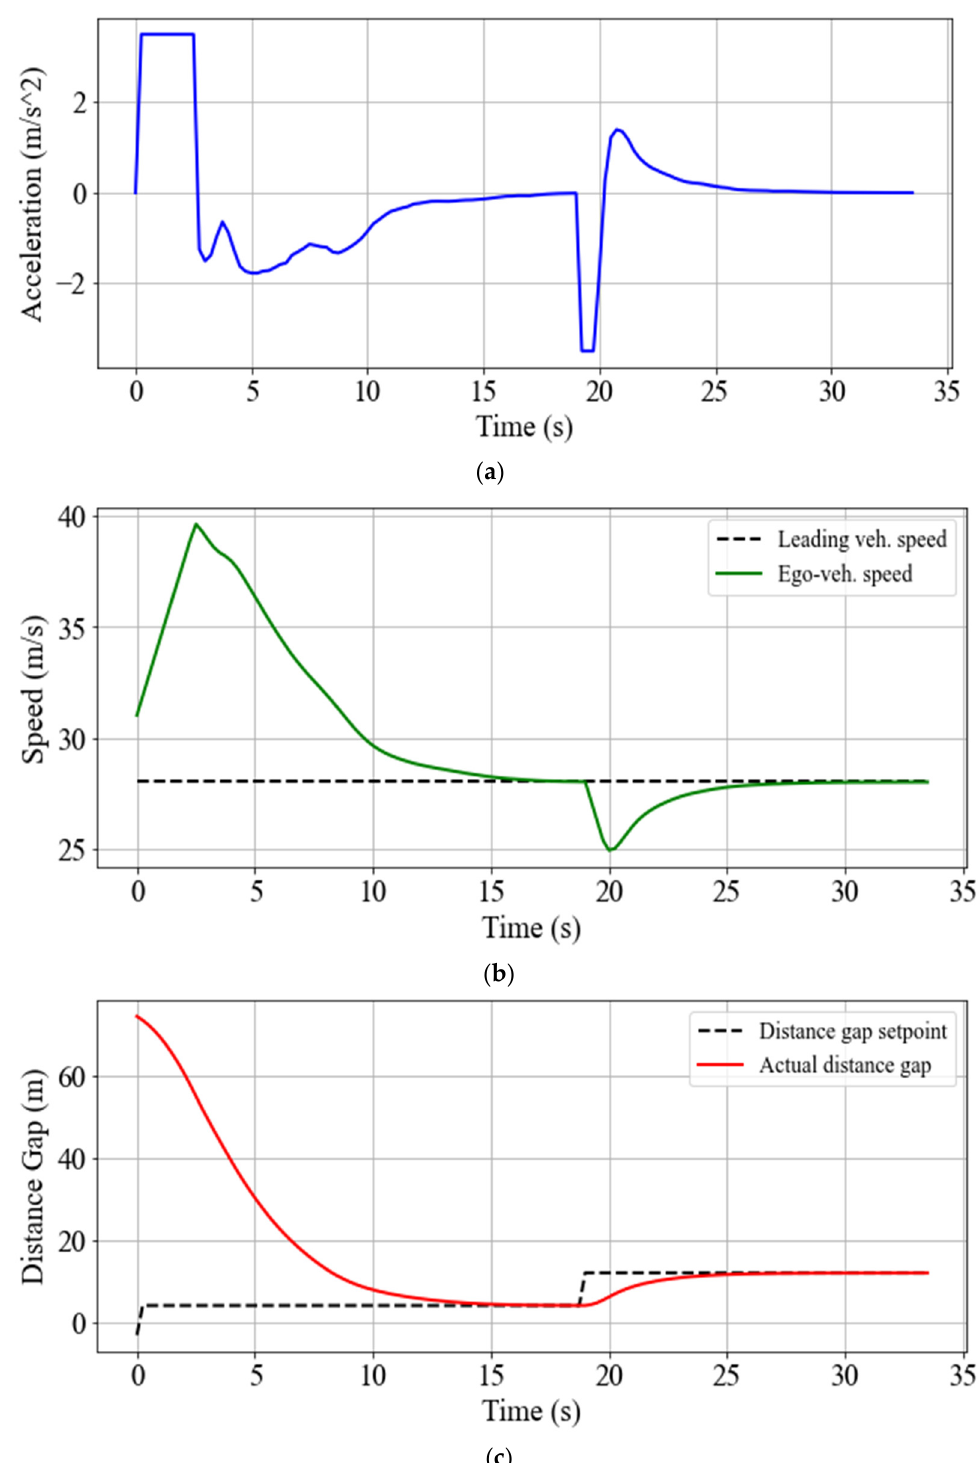
Figure 4. Acceleration ( a ), speed ( b ), and distance-gap ( c ) variations in the ego-vehicle during gap-